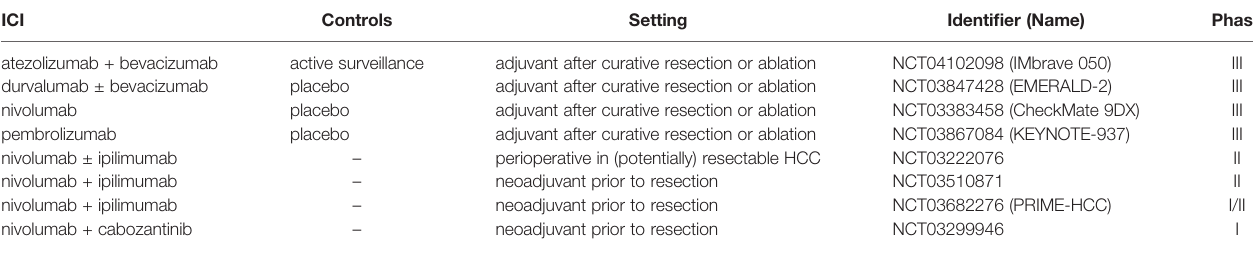
TABLE 2 | Ongoing clinical trials of (neo)adjuvant immunotherapy for hepatocellular carcinoma (HCC). ICI